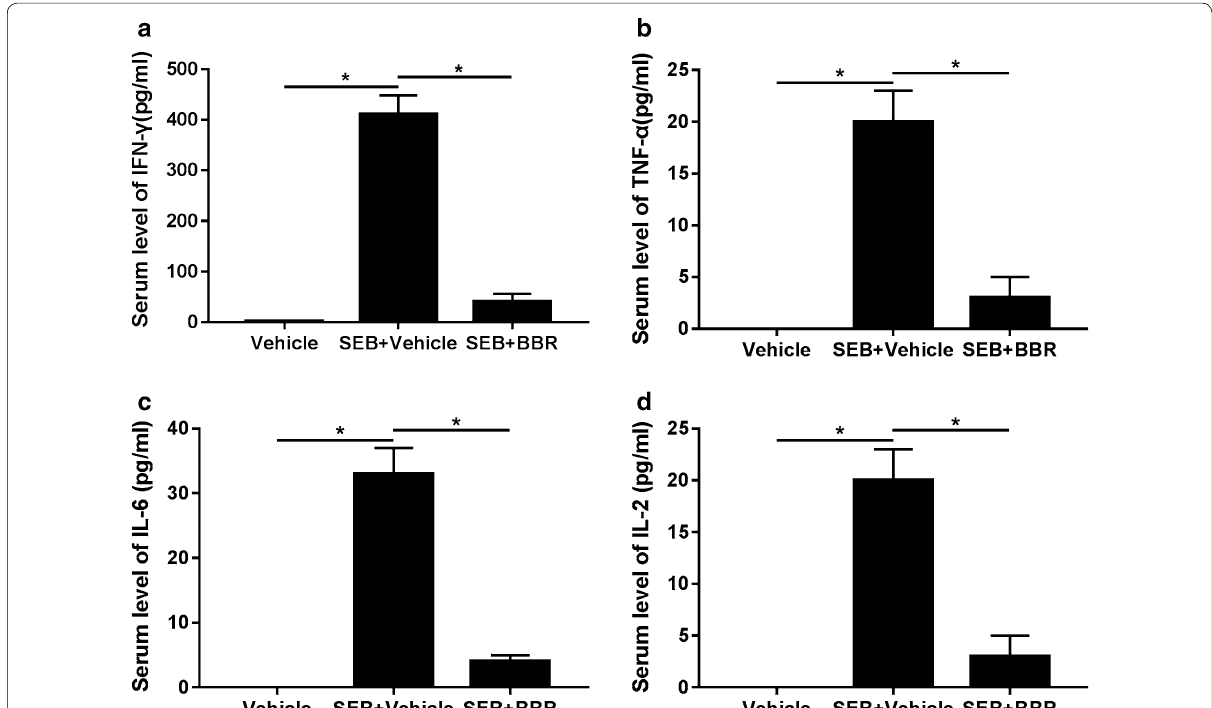
Fig. 2 BBR alleviated SEB-induced inflammation in the liver. The levels of IFN-γ a , TNF-α b , IL-6 c and IL-2 d in the serum from mice sensitized with d -gal and treated with SEB or combined with BBR and were examined by ELISA. The level of IFN-γ, TNF-α, IL-6 and IL-2 in vehicle was 5.89 ± 1.22, 0.16 0.02, 0.23 0.02, 0.11 0.01, respectively. * P < 0.05. SEB Vehicle group versus Vehicle or SEB ± ± ± +